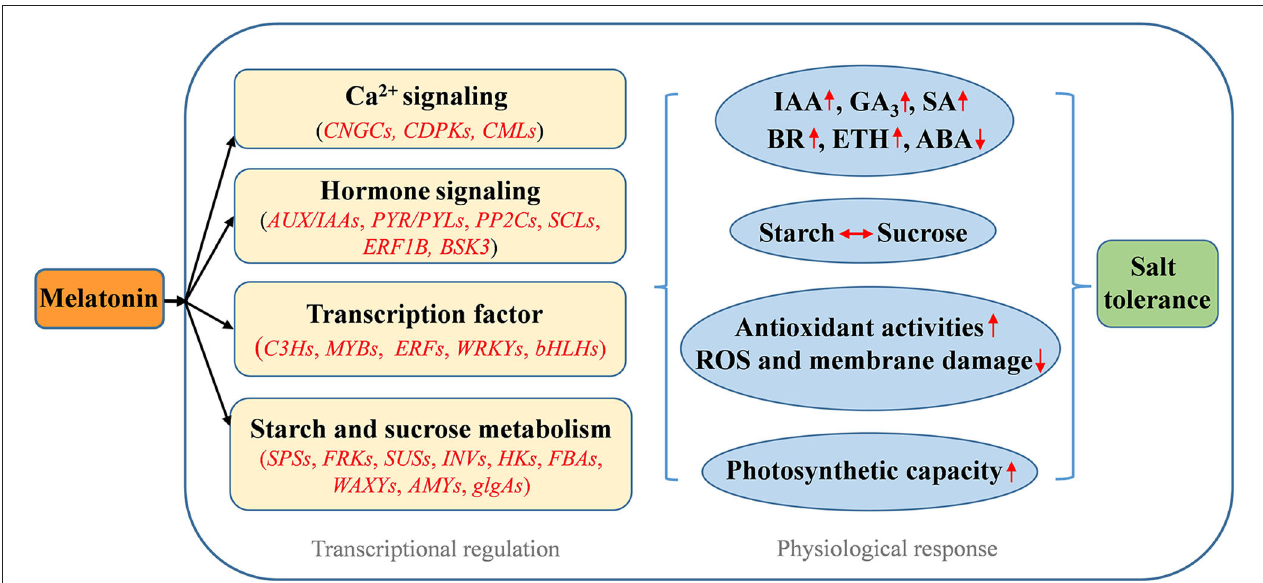
FIGURE 10 | Schematic model for melatonin-induced salt stress tolerance in